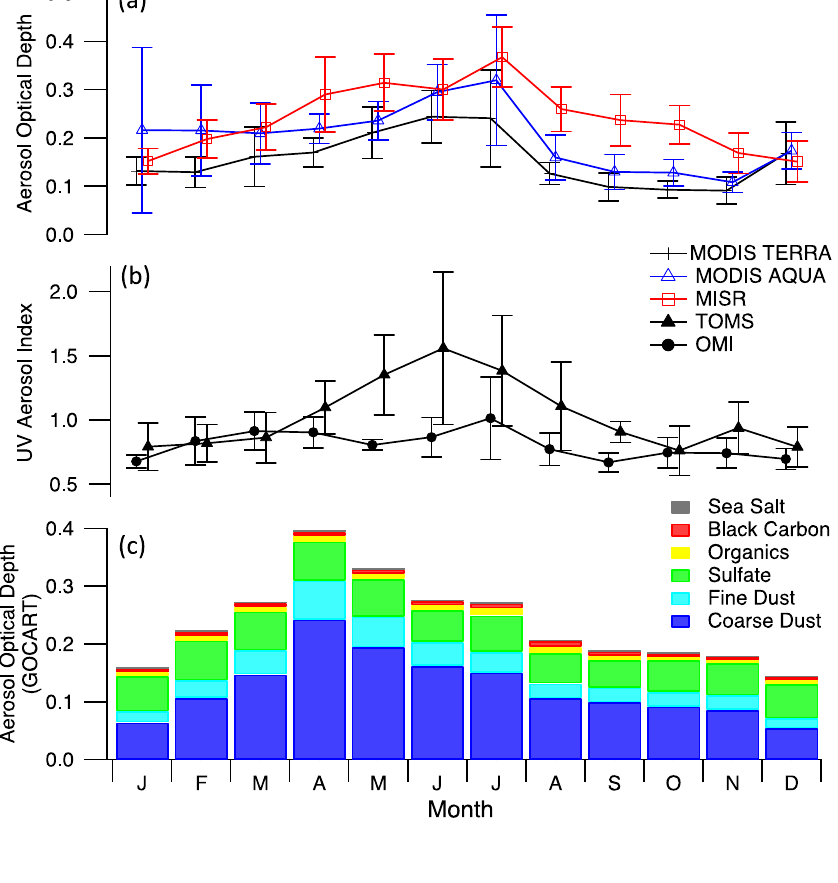
Figure 6. Monthly summary of remotely-sensed and model data for the greater Tehran area (see Table 1) for different satellite products (a and b): ( a ) aerosol optical depth (AOD) from MODIS Deep Blue (Terra and Aqua) and Multi-angle Imaging Spectroradiometer (MISR); ( b ) Total Ozone Mapping Spectrometer (TOMS) and Ozone Monitoring Instrument (OMI) ultraviolet aerosol index; ( c ) monthly summary of fractional AOD from Goddard Ozone Chemistry Aerosol Radiation and Transport